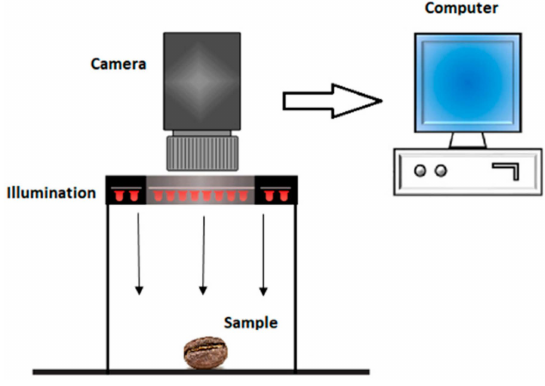
Figure 2. Proposed vision